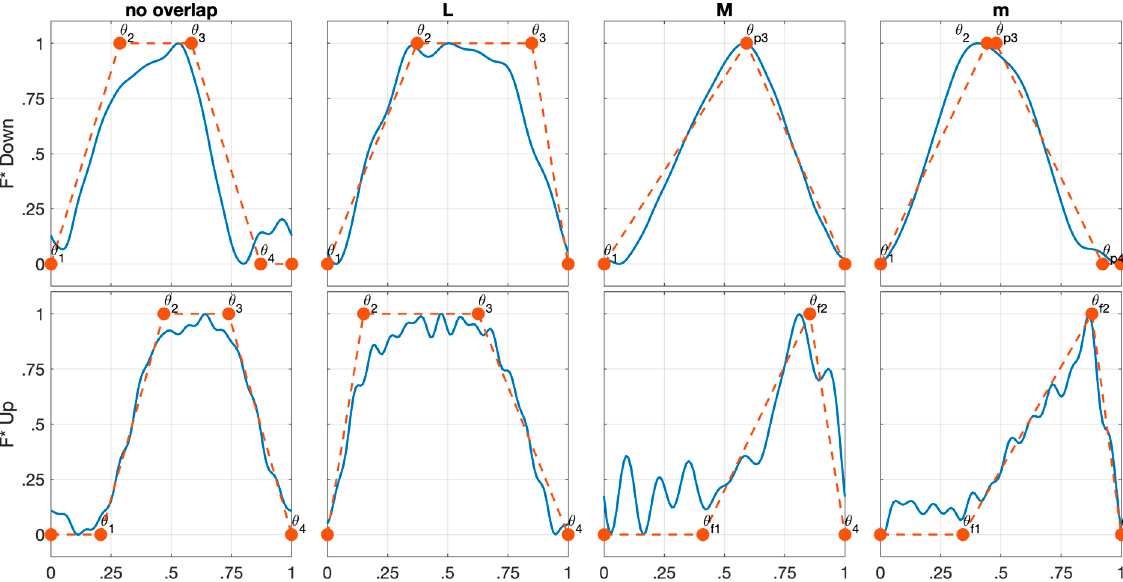
Figure 10. Type IIb normalized F shapes (tests 19 to 22 in down-milling; tests 23 to 26 in up-milling).